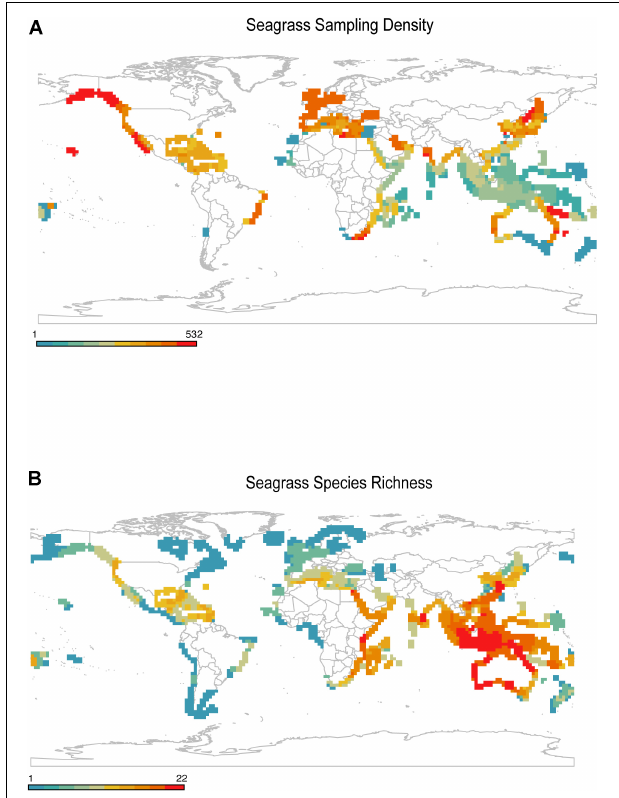
FIGURE 3 | Gaps in geographic sampling of seagrasses. (A) Seagrass occurrence records showed strong density of sampling in temperate regions, while sampling within the tropics was generally low. (B) Geographic distribution of seagrass known species richness based on expert delineated polygons. Source data are provided as a Source Data